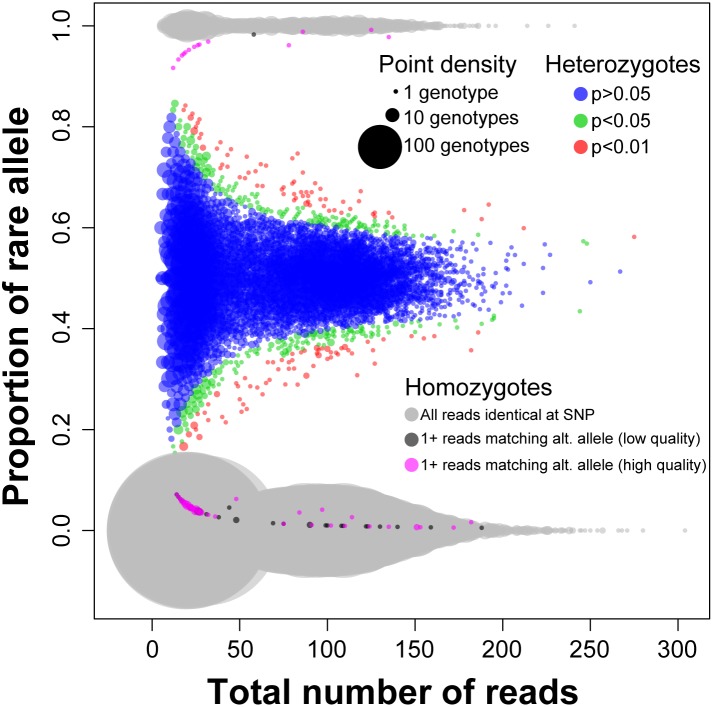
Read counts for indigobird ddRAD loci with a single bi-allelic SNP.Data are shown for 1,721 loci recovered in all 46 indigobirds in the RAD10 sequencing run (n = 79,166 genotypes). The area of data points is proportional to the number of individual genotypes at each coordinate. Read counts for heterozygous genotypes (n = 11,761) were consistent with random sampling from a binomial distribution with probability 0.5 (i.e., Mendelian expectations), resulting in a strongly trimodal distribution of read counts. Most homozygous genotypes (n = 67,405) were based on 100% of reads (light grey) matching one of the two alleles at a given locus; only 64 genotypes (0.09%) scored as homozygous had one or more high quality reads (magenta) matching the alternative allele.